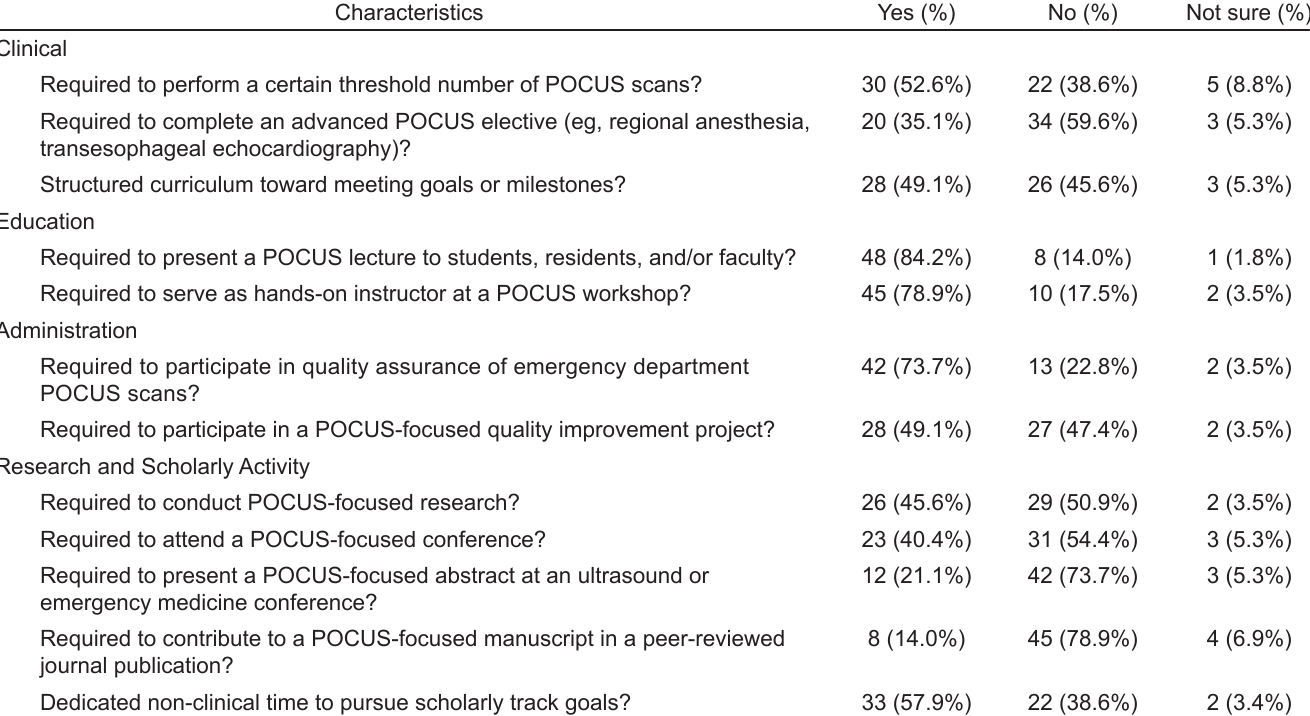
POCUS, point-of-care